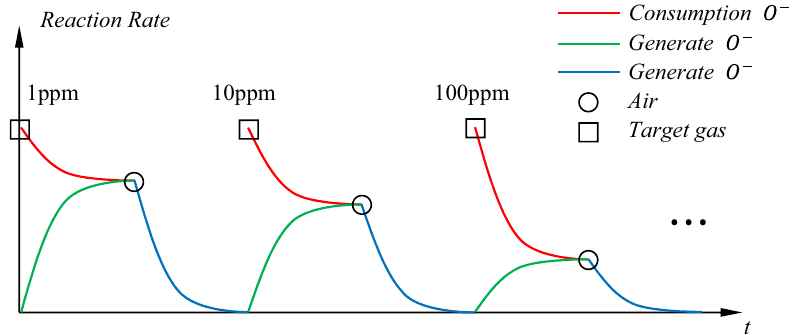
Figure 2. A diagram of the rate of chemical reactions at different acetone concentrations. The squares and circles represent the introduction of target gas and air into the test environment, respectively. The red line represents the rate of consumption oxygen ions. The blue and green lines indicate the rate of generation oxygen ion in the presence/absence of competing